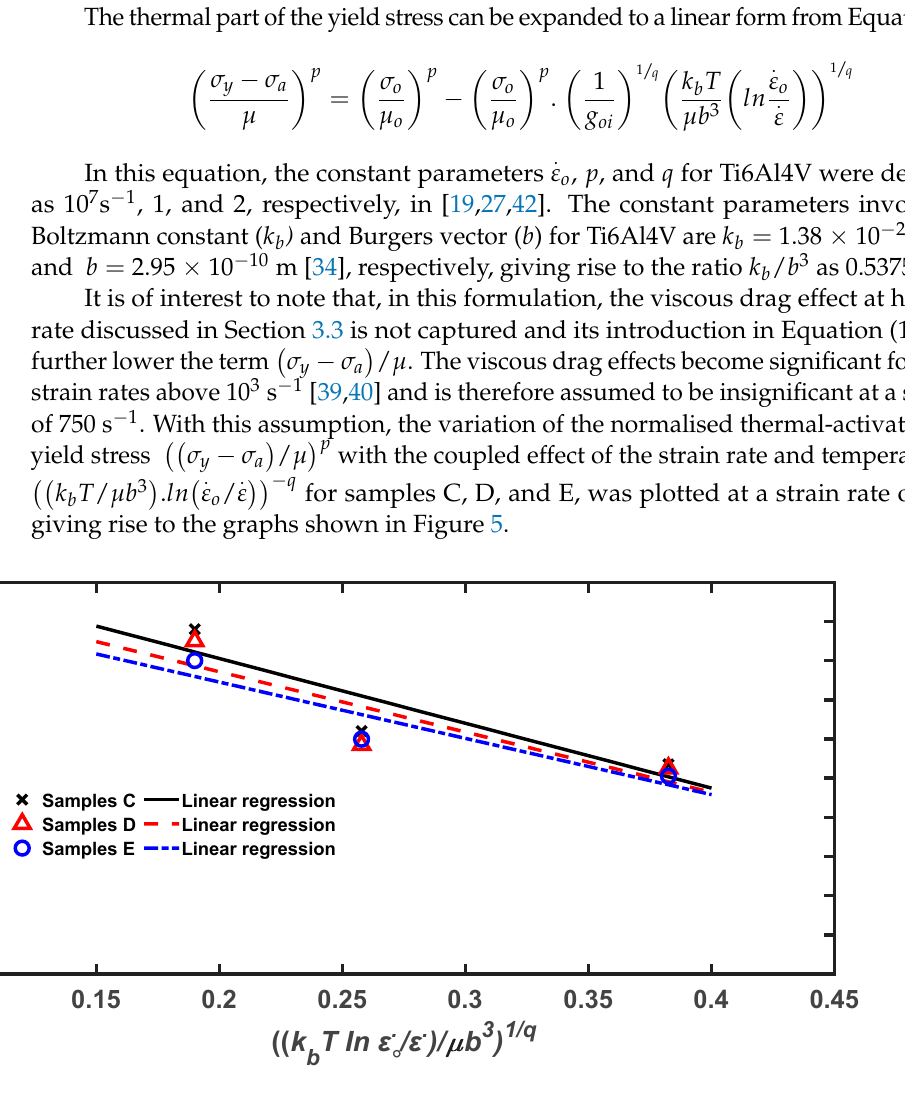
Figure 5. The normalised thermal-activated part of yield stress against the effects of temperature at a strain rate of 750 s − 1 . The mechanical threshold stress ( 𝜎 (cid:3042) ), which is the thermal-activated component of yield stress at 0 K , and the average value of normalised activation energy ( 𝑔 (cid:3042)(cid:3036) ) are given tively. The values of these model-fitting parameters for samples C, D, and E, obtained